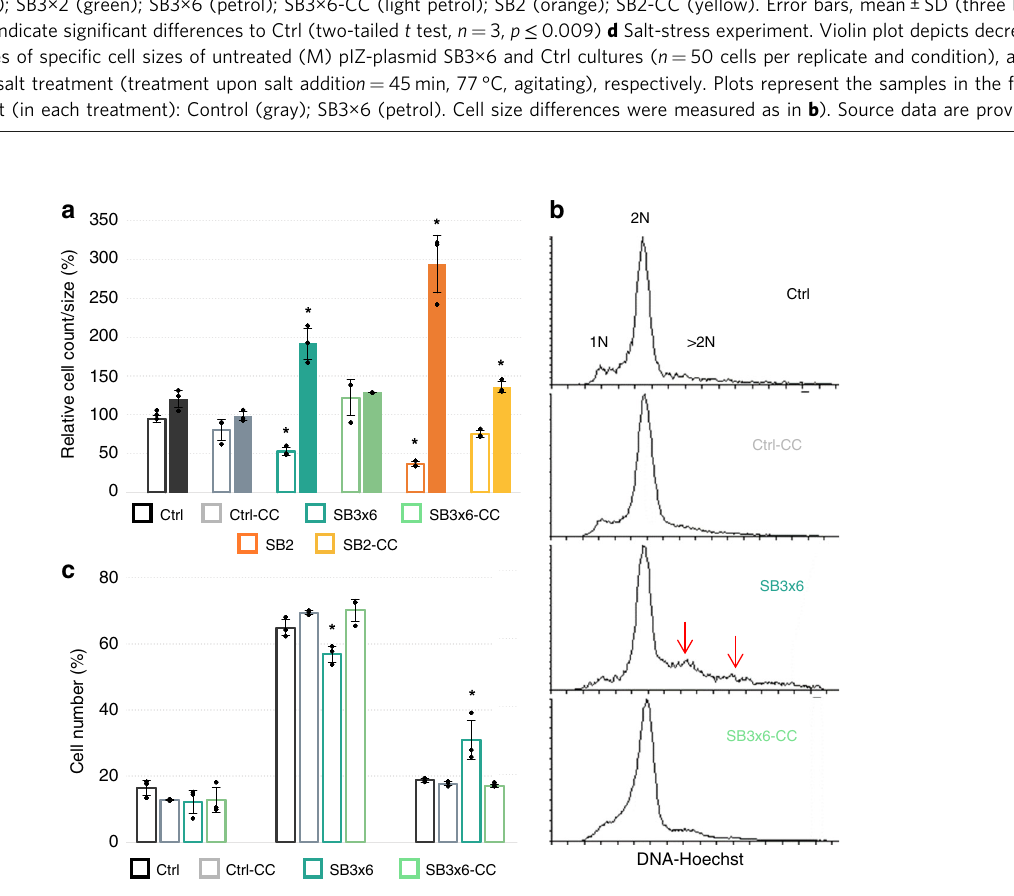
Fig. 6 Correlation of cell count, size, and DNA content in silenced and control cultures of pIZ-cultures. a Differences in cell counts (cells per ml) determined by fl ow cytometry (calculated from fl ow rate) and cell size (FSC, n = 10,000 per biol. repl.) of same cultures harvested at precisely OD 600 = 0.1 and normalized to Ctrl control. Cell counts: empty bars, cell size: fi lled bars. Bars in the graph represent the samples in the following order from left to right (for both conditions): control (dark gray); control-CC (light gray); SB3×6 (petrol); SB3×6-CC (light petrol); SB2 (orange); SB2-CC (yellow). Error bars, mean ± SD (three biol. repl.). Asterisks indicate signi fi cant differences to Ctrl (two-tailed t test, n ≥ 3, p ≤ 0.018). b Fluorescence histograms of Ctrl, Ctrl-CC, SB3×6, SB3×6-CC pIZ-plasmid cultures harvested at OD 600 = 0.1 and stained with Hoechst. Peaks represent cell abundances containing one chromosome (1 N), two chromosomes (2 N), and more than two chromosomes (>2 N) in respective cultures (created with Flowing Software 2.5.1 ). c Percentage of cells containing de fi ned chromosome numbers in each culture (as in b ): 1 N (left bars), 2 N (middle bars), >2 N (right bars). Bars in the graph represent the samples in the following order from left to right (in every section): Control (dark gray); control-CC (light gray); SB3×6 (petrol); SB3×6-CC (light petrol). Error bars, mean ± SD (three biol. repl.). Asterisks indicate signi fi cant differences to Ctrl (two-tailed t test, n ≥ 3, p ≤ 0.049). Source data are provided